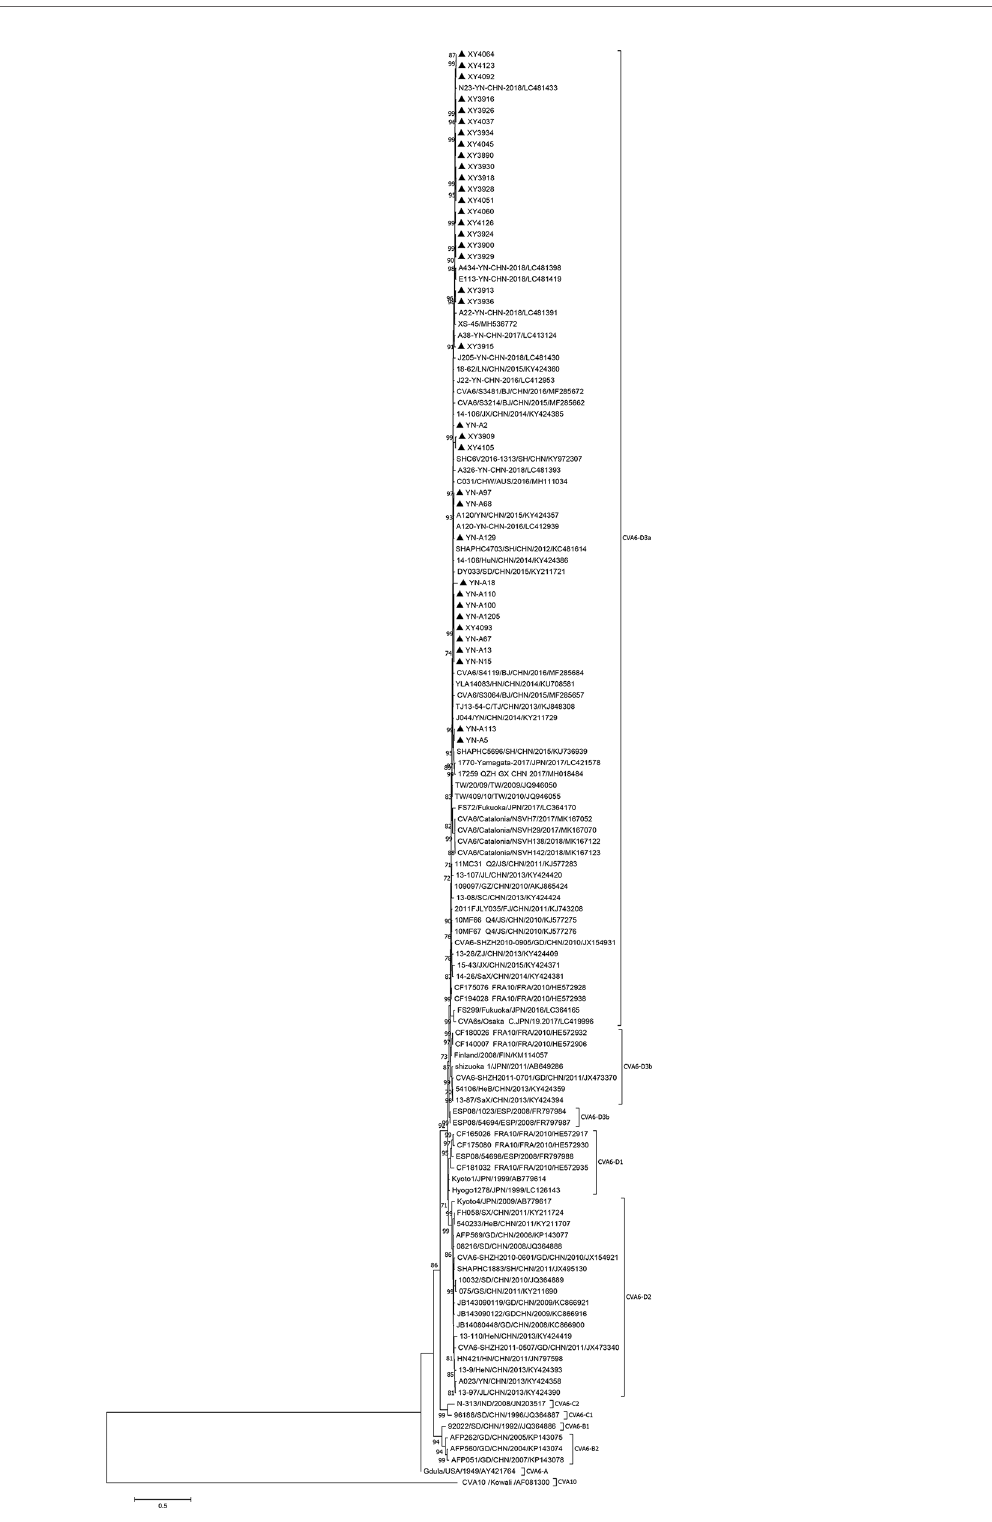
Frontiers in Cellular and Infection Microbiology |